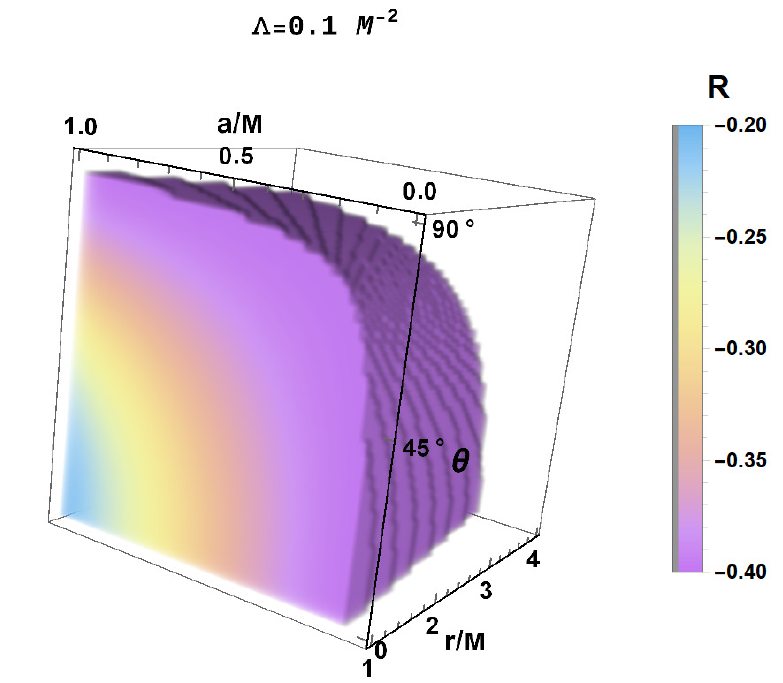
Figure 1. Density plot of the curvature in the vicinity of the Kerr–de Sitter black hole elucidating the warping